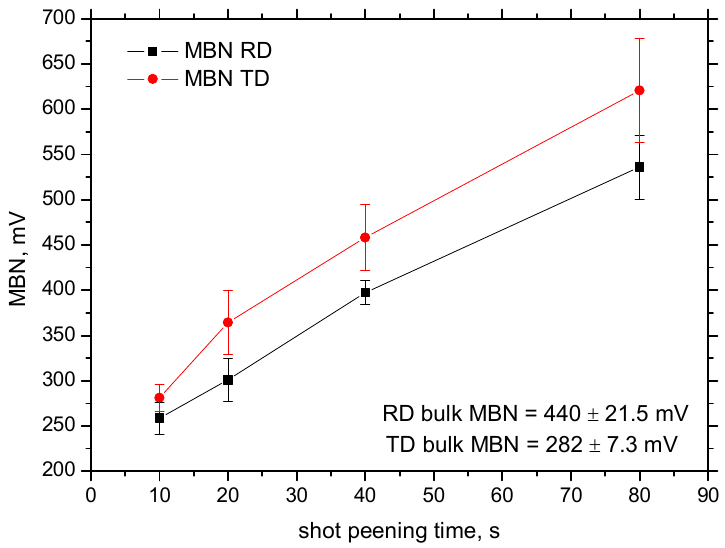
Figure 7. MBN (root mean square (RMS) value) after shot peening.